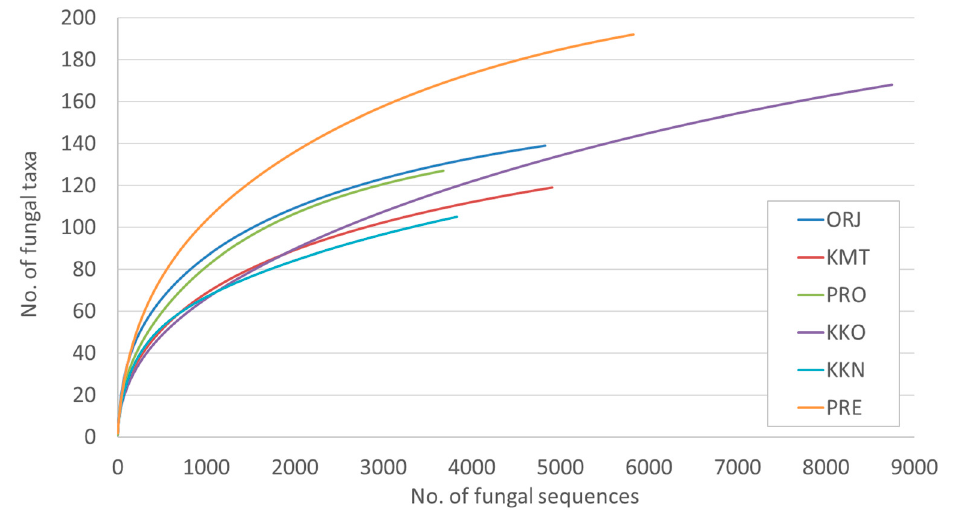
Figure 3. Rarefaction curves showing the relationship between the cumulative number of fungal taxa and the number of ITS2 rDNA sequences from needles of Pinus heldreichii from six different sites. Information on the 25 most common fungal taxa representing 79.0% of all fungal sequences is in Table 3. The most common fungi in the phyllosphere of P. heldreichii were Lophodermium pinastri (12.5% of all fungal sequences), Lophodermium conigenum (10.9%), Sydowia polyspora (8.8%), Cyclaneusma niveum (5.5%) and Unidentified sp. 2814_1 (5.4%) (Table 3). The most common fungal pathogens of pine needles were S. polyspora (8.9%), C. niveum (5.5%), Neocatenulostroma germanicum (2.3%) ,